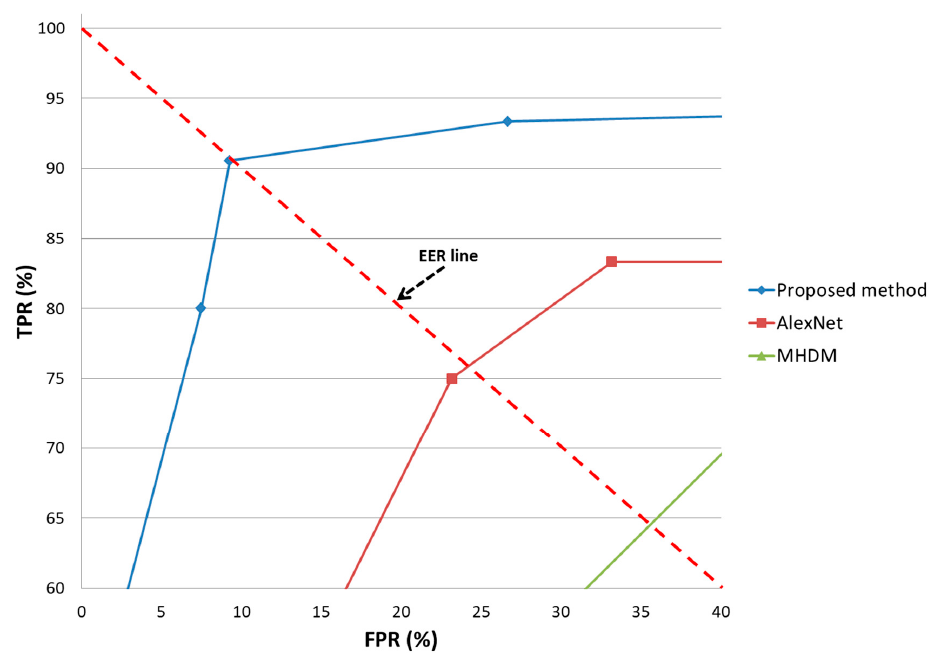
Figure 15. ROC curves of proposed method and its comparison with previous methods on Open database